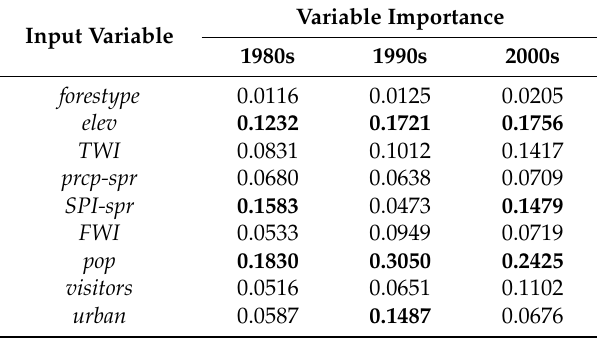
Table 3. Variable importance of each input variable to forest fire probability during the 1980s, 1990s, and 2000s (Random Forest analysis).